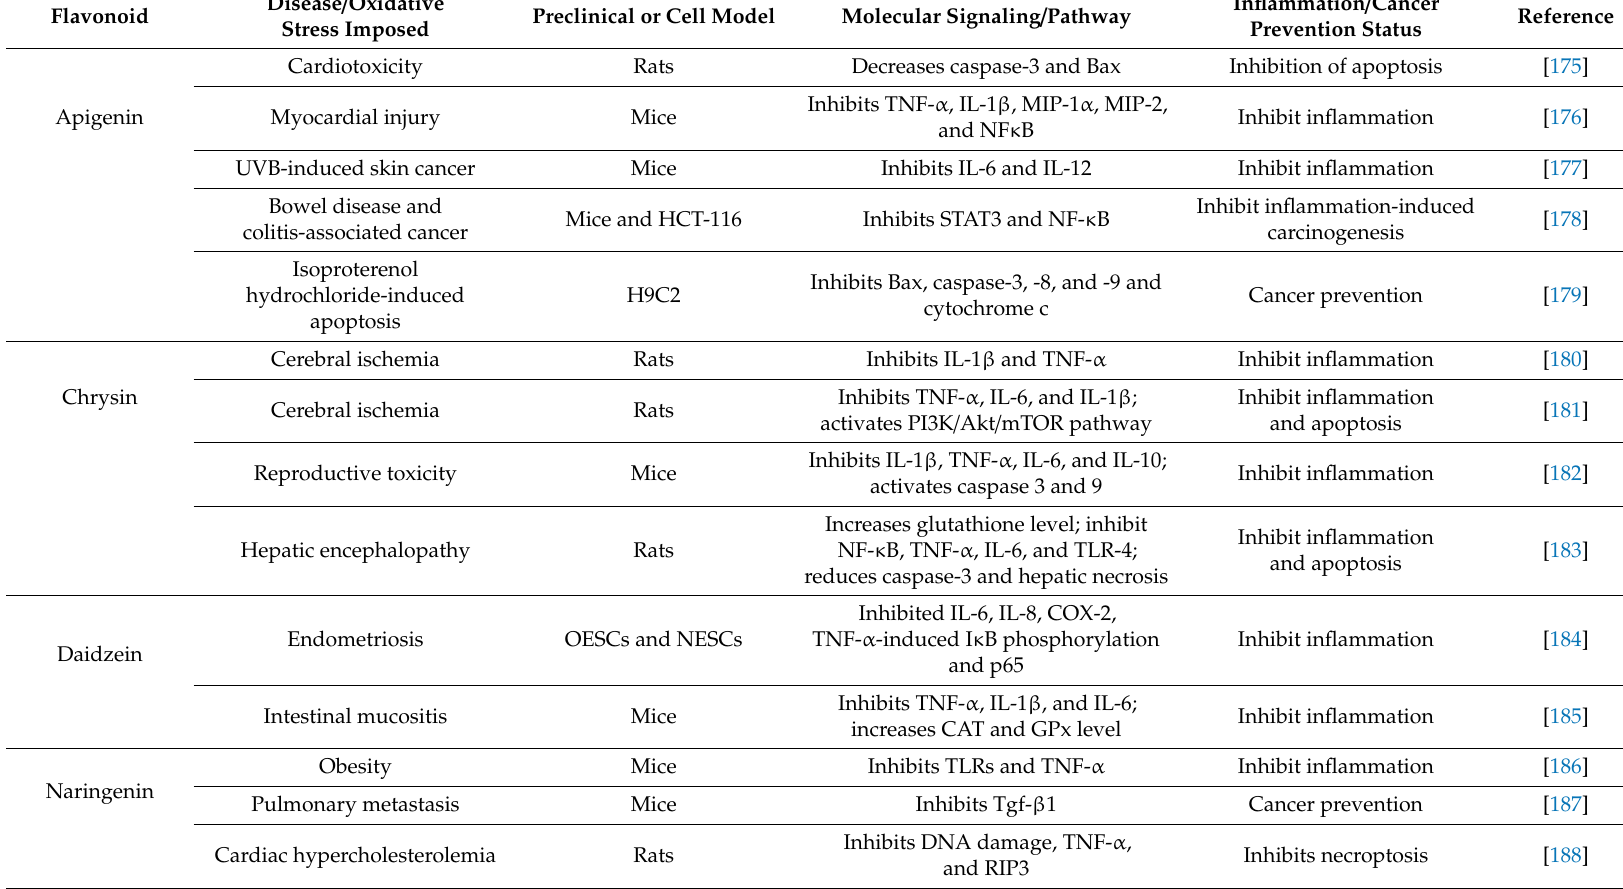
Table 1. Flavonoids in preventing inflammation and cancer in preclinical and experimental cell